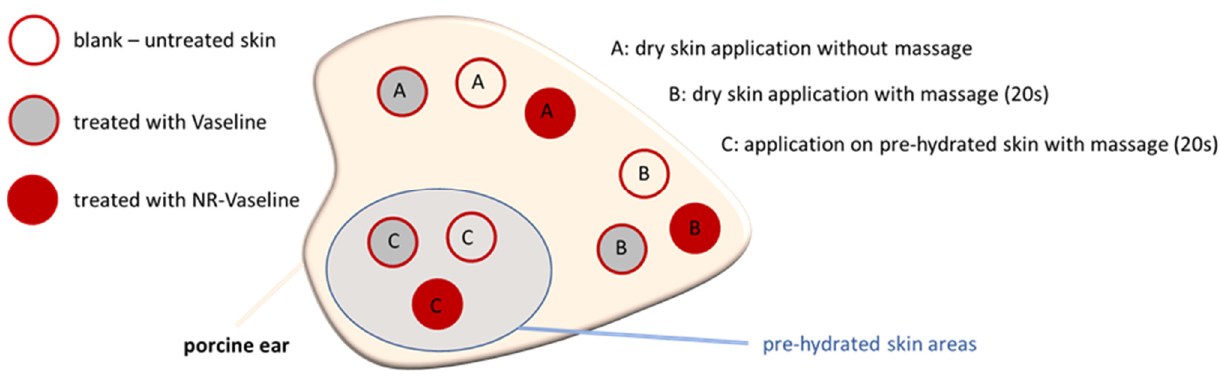
Figure 1. Experimental design for the determination of the dermal penetration efficacy. Experiments were performed in triplicate, i.e., on three different, independent ears.